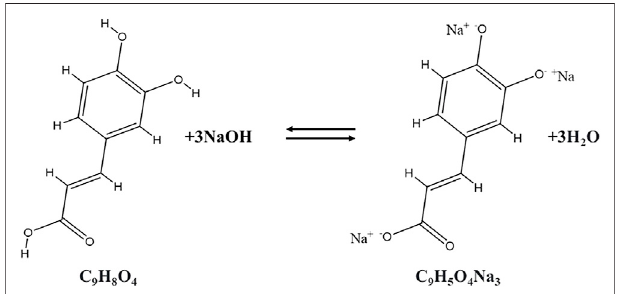
FIGURE 3 | Reaction to obtain Na 2 -CA from CA.